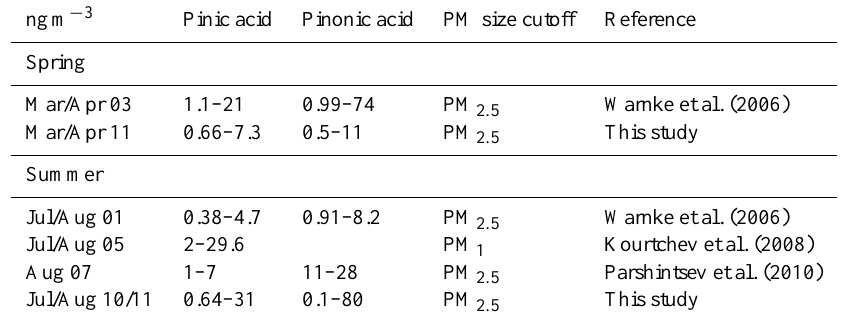
Table 2. Concentrations of pinic and pinonic acids in comparison to previous studies at the SMEAR II station in